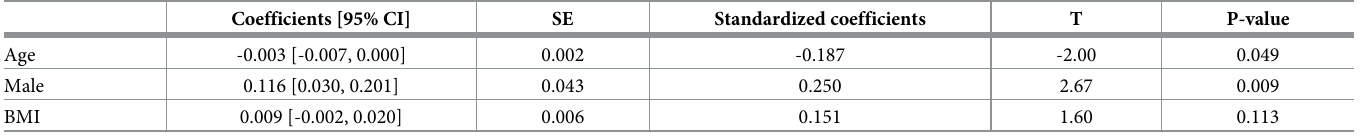
Table 3. Multiple regression analysis (60 min after the surgical incision).